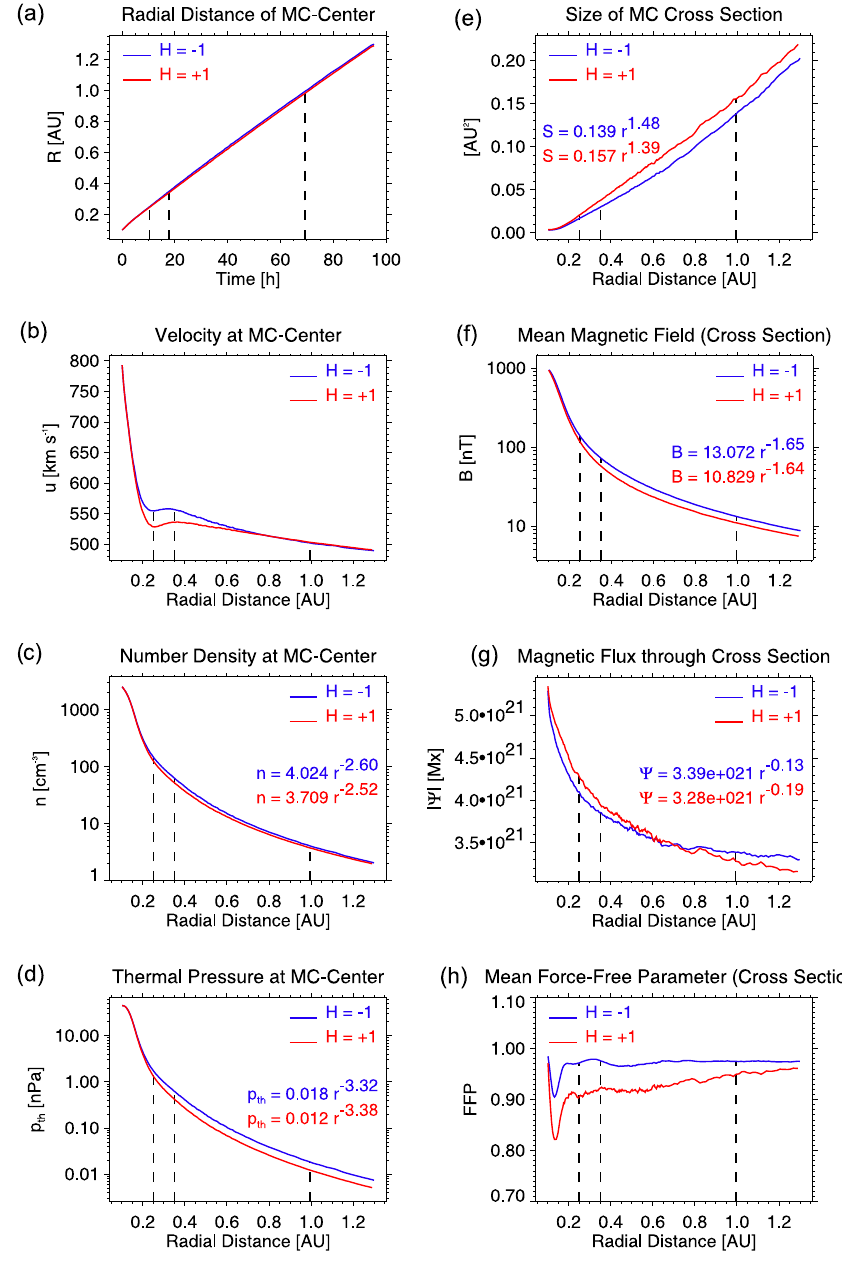
Fig. 17. Radial evolution of parameters at the MC-center (left column) and of parameters which are computed over the whole MC cross section (right column) for H − m (blue) and H + m (red). Radial fits computed for the range 0 . 3 − 1 . 0AU are listed where